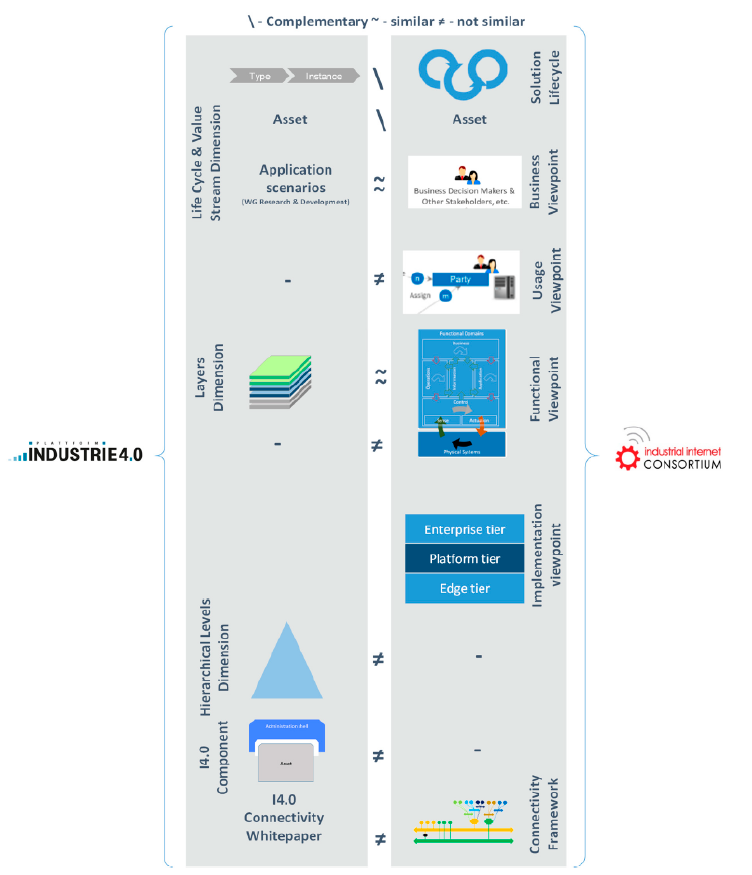
Figure 5. Industrial Internet Consortium alignment between RAMI 4.0 and IIRA